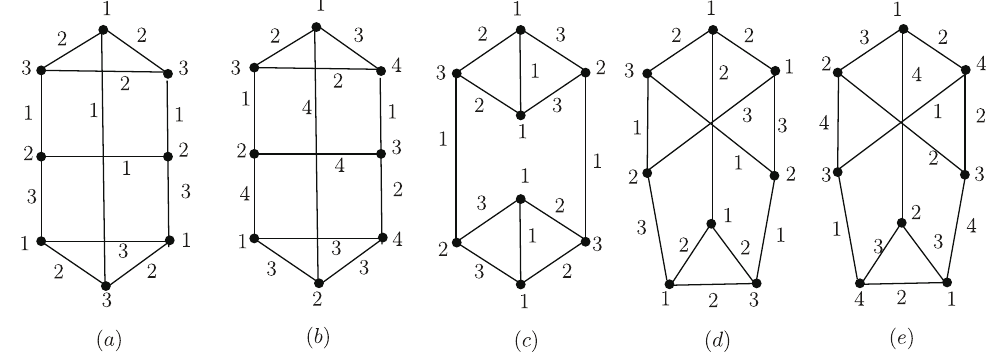
Figure 4: The total proper k - connected coloring of F 1 , F 2 and F 3